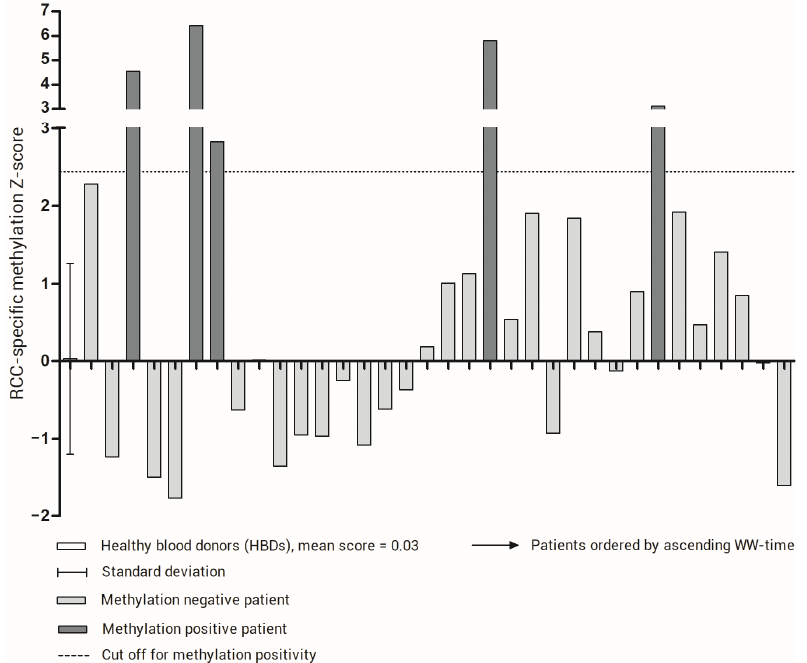
Figure 2. RCC-specific methylation score for healthy blood donors (HBDs) and patients. For HBDs, the mean and standard deviation is indicated. The cut-off for methylation positivity, represented by the upper limit of the 95% confidence interval of the methylation score in HBDs, is indicated by a dotted line. The patients are ordered by WW time.